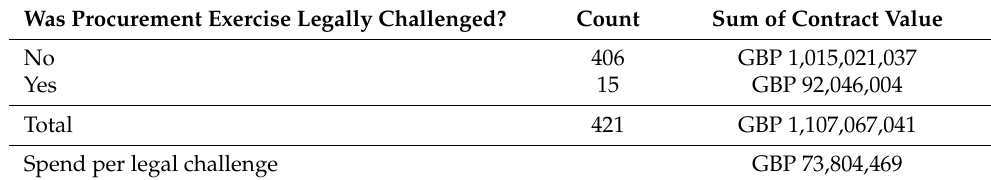
Table 6. Breakdown of procurement exercises where contract award value was provided.